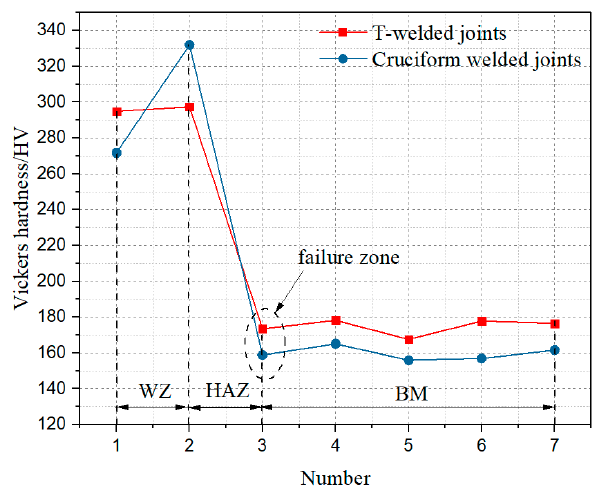
Figure 13. Vickers hardness profiles at − 60 °C.